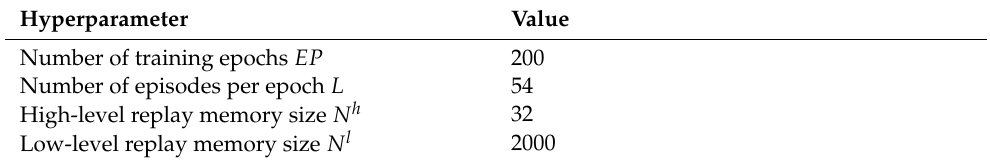
Table 4. List of hyperparameters and their